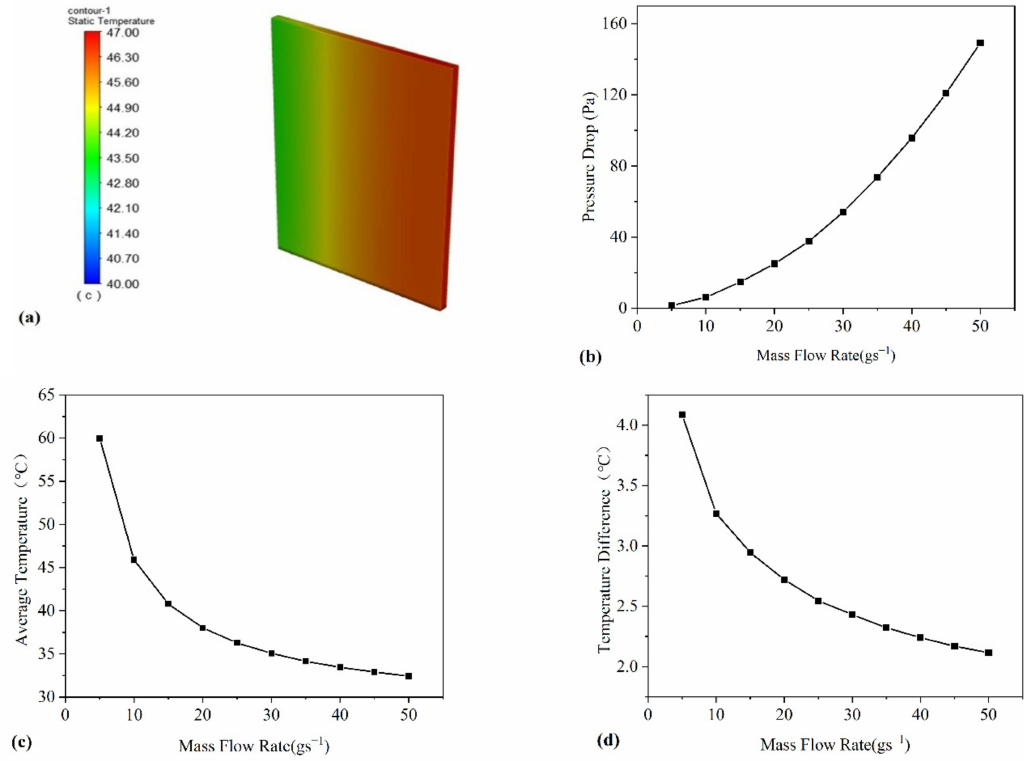
Figure 3. Air-cooling BTMS without AFHS: ( a ) temperature distribution of battery at q m = 10 gs − 1 , ( b ) pressure drop, ( c ) average temperature, and ( d ) temperature